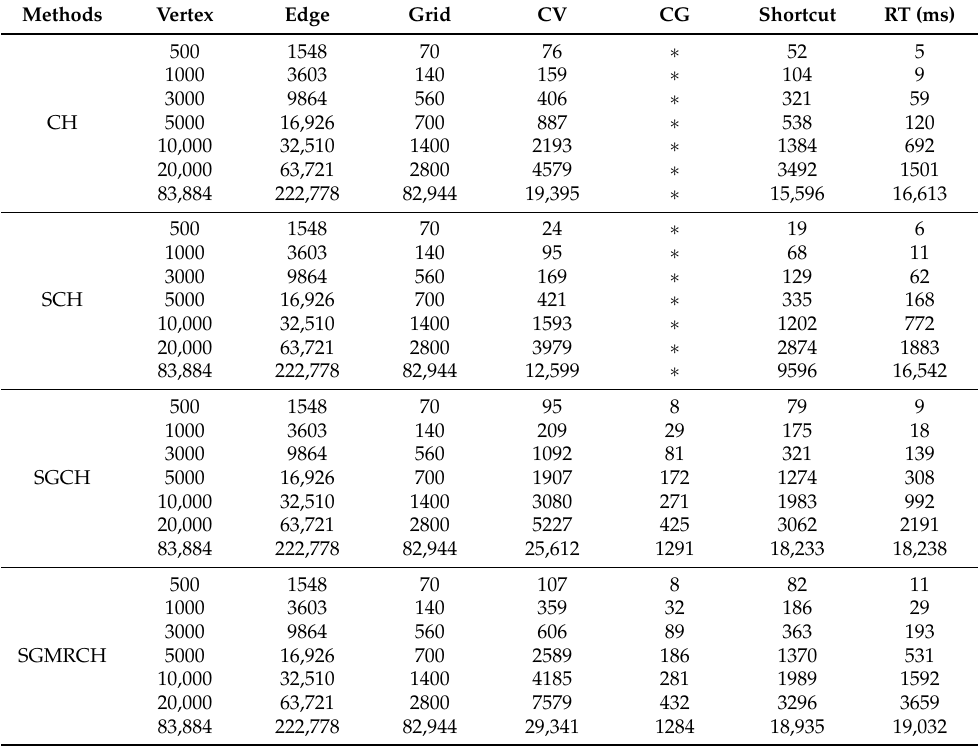
Table 8. Comparison with different graph contraction